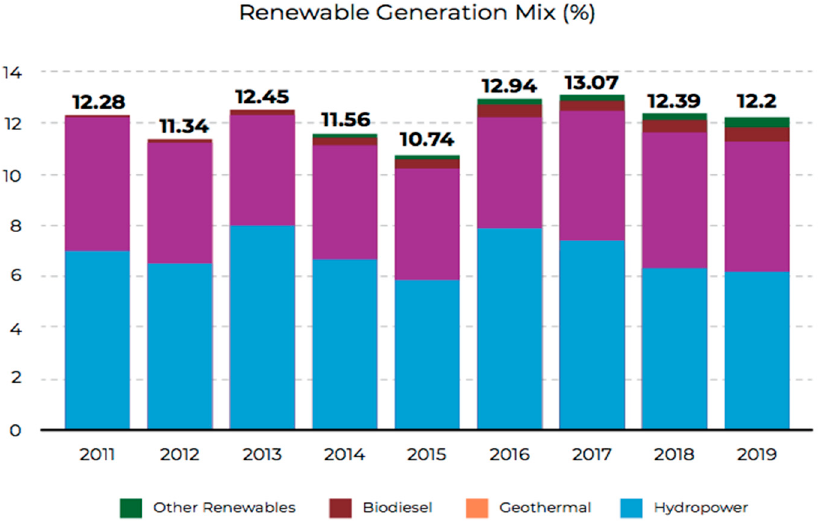
Figure 4. Indonesia renewable energy mix 2011–2019 (developed by author based on [33]).